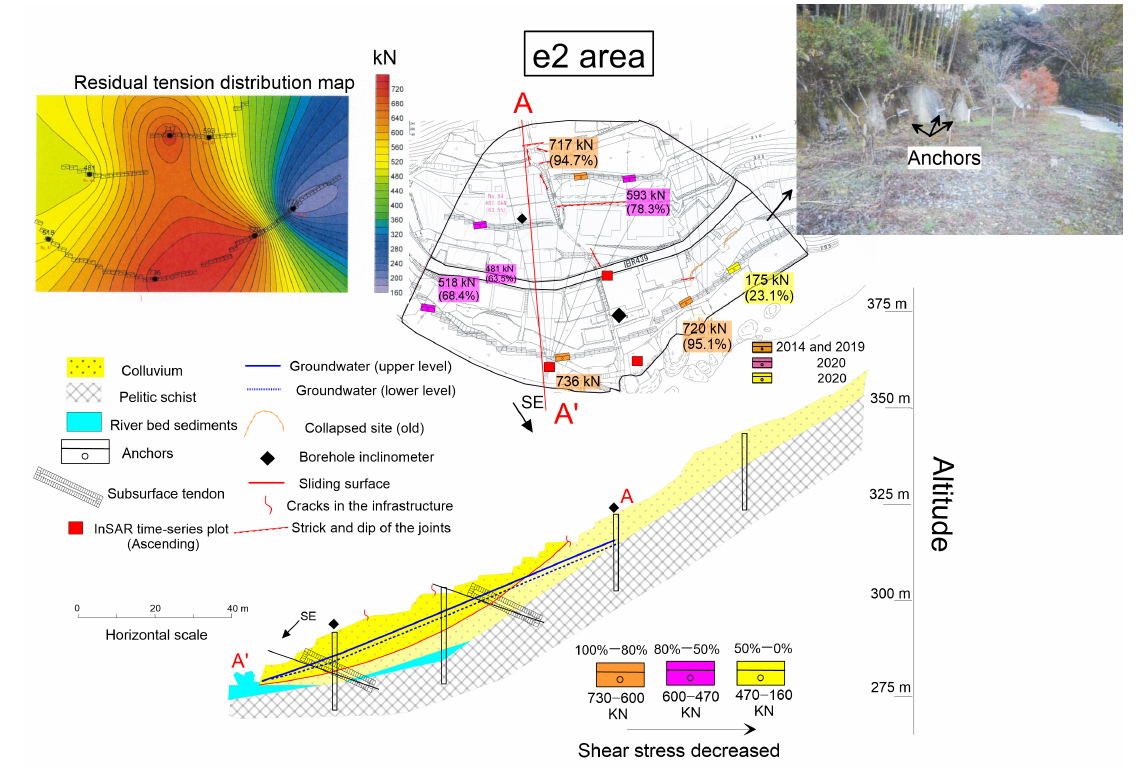
Figure 3. Anchor tension distribution map and the locations of anchors in Otoyo Town associated with the Kawai landslide and e2 area. The cross-section A–A’ shows the geological and geomorphological setting, borehole inclinometer locations, and subsurface tendons of the anchors. The shear stress gradually decreased after anchor maintenance in 2020, and anchors are indicated by in pink and yellow colors.